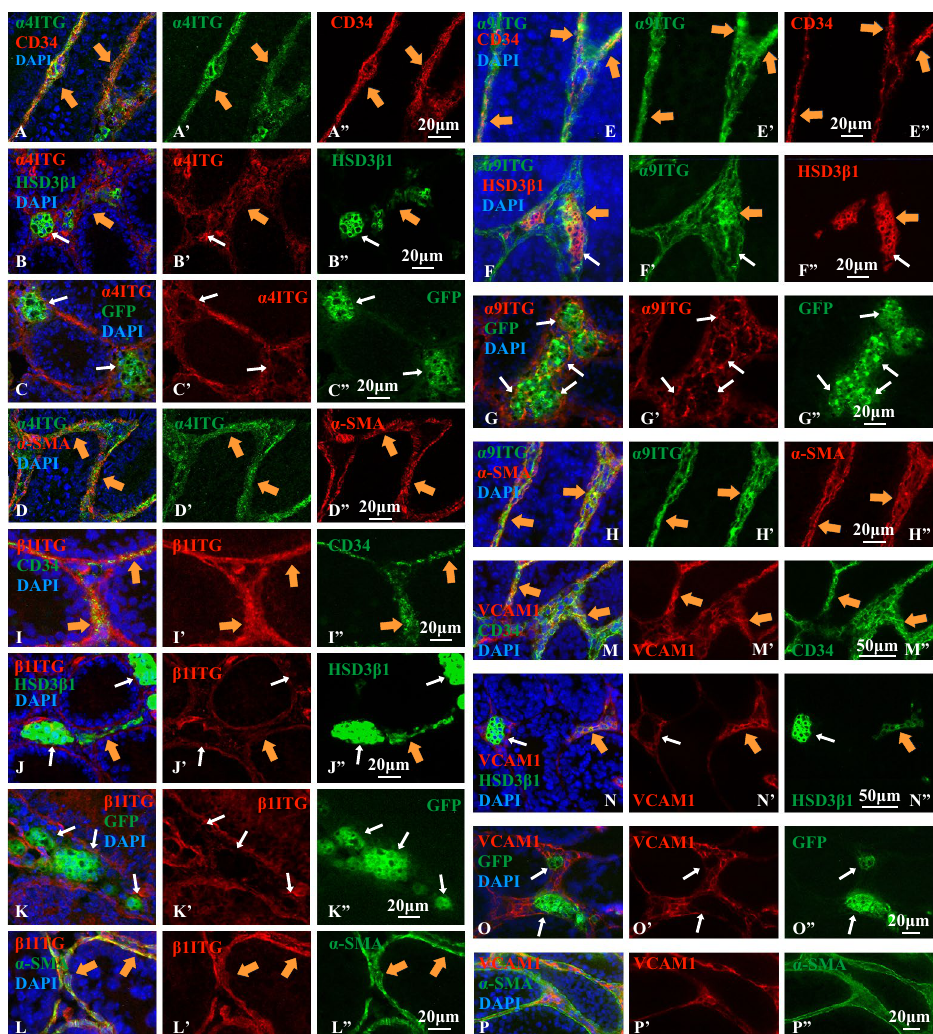
Figure 2. Immunofluorescence staining showed that integrins α4, α9 and β1 are expressed in CD34 + cells, ALCs and PMCs, but not in FLCs in 14-dpp testes. VCAM1 is also expressed in CD34 + cells and ALCs, but not in FLCs or PMCs. For co-staining with antibodies against GFP and those against integrin α4, α9 or β1, testes from mFLE-EGFP transgenic mice were used. ( A – D ″ ) Double staining for α4 integrin (ITG) ( A , A’ , B , B’ , C , C’ , D , D’ ), and CD34 ( A , A ″ ), HSD3β1 ( B , B ″ ), GFP ( C , C ″ ), or α-SMA ( D , D ″ ). ( E – H ″ ) Double staining for α9 ITG ( E , E’ , F , F’ , G , G’ , H , H’ ), and CD34 ( E , E ″ ), HSD3β1 ( F , F ″ ), GFP ( G , G ″ ), or α-SMA ( H , H ″ ). ( I – L ″ ) Double staining for β1 ITG ( I , I’ , J , J’ , K , K’ , L , L’ ) and CD34 ( I , I ″ ), HSD3β1 ( J , J ″ ), GFP ( K , K ″ ) or α-SMA ( L , L ″ ). ( M – P ″ ) Double staining for VCAM1 ( M , M’ , N , N’ , O , O’ , P , P’ ), and CD34 ( M , M ″ ), HSD3β1 ( N , N ″ ), GFP ( O , O ″ ) or α-SMA ( P , P ″ ). Cells were also stained with DAPI in ( A – P ). Thick orange arrows indicate regions where expressions of 2 antigens were overlapped among 3 photographs which were labeled with the same letter (e.g. A , A’ , and A ″ ). White thin arrows show regions where expression of HSD3β1 or GFP was not overlapped with that of α4, α9, and β1ITGs and VCAM1 (e.g. C , C’ , and C ″ ). All of the negative controls for the antibodies used were shown in Supplementary Fig.